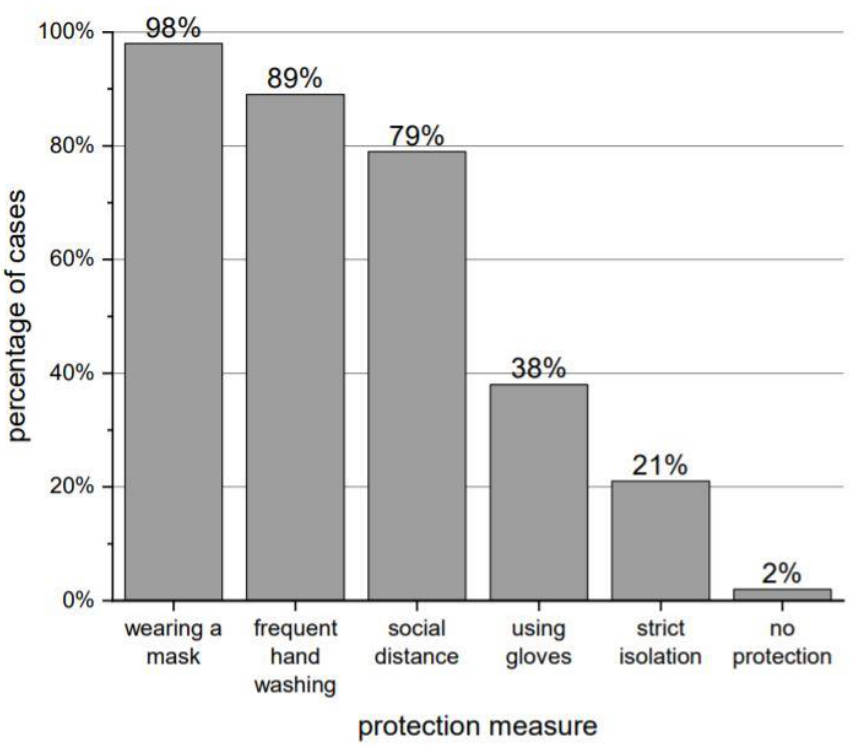
Figure 2. The most commonly used protection to prevent SARS-CoV-2